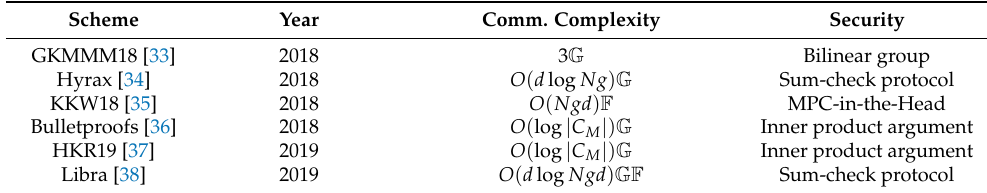
Table 4. Summary of zero-knowledge proof in recent 5 years. Comm. is short for communication. F denotes the field elements and G denotes the group elements. C M represents the number of multiplication gates in the circuit. The data-parallel circuits can be divided into N sub-circuits with width g and depth d . Let λ be a security parameter. β SIS denotes the Module-SIS solution norm. n denotes the required dimension in the lattice